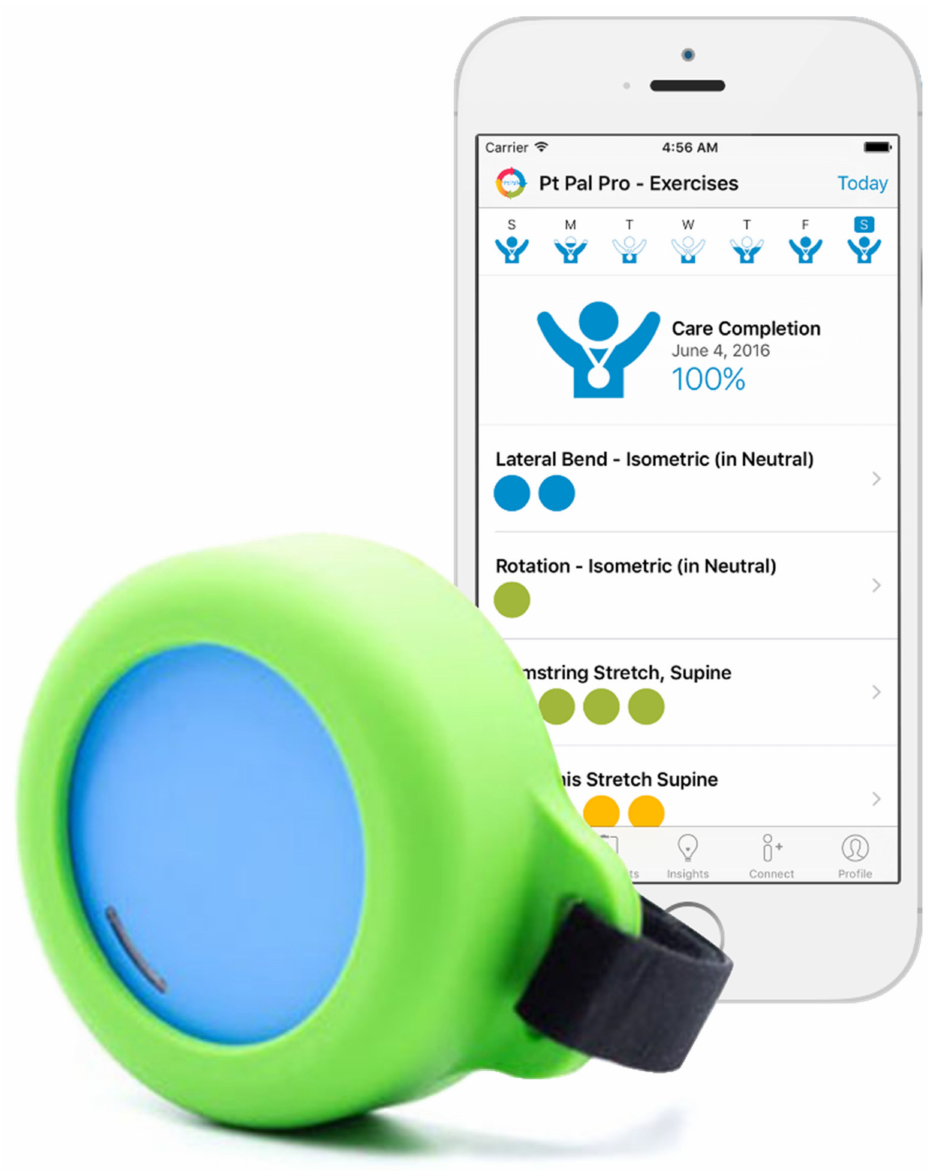
Figure 1. FitMi sensorized puck (blue) and silicone–Velcro strap (green) and Pt Pal patient app. The puck can be held and moved, squeezed, placed on a table or the floor and pressed, or strapped to a